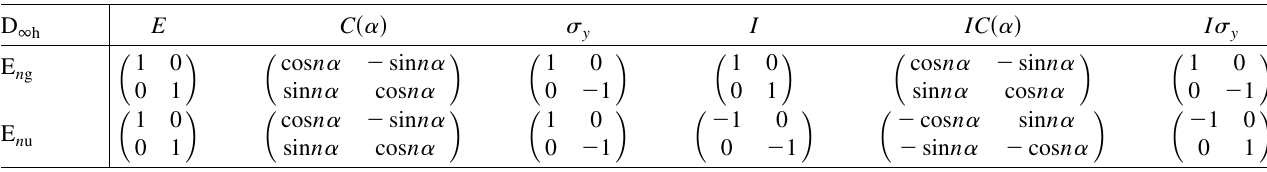
and E , of the group D 1 n g n u